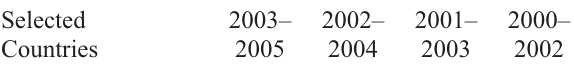
Table 1. The Inward FDI Performance Index Rankings Se lec ted Countries